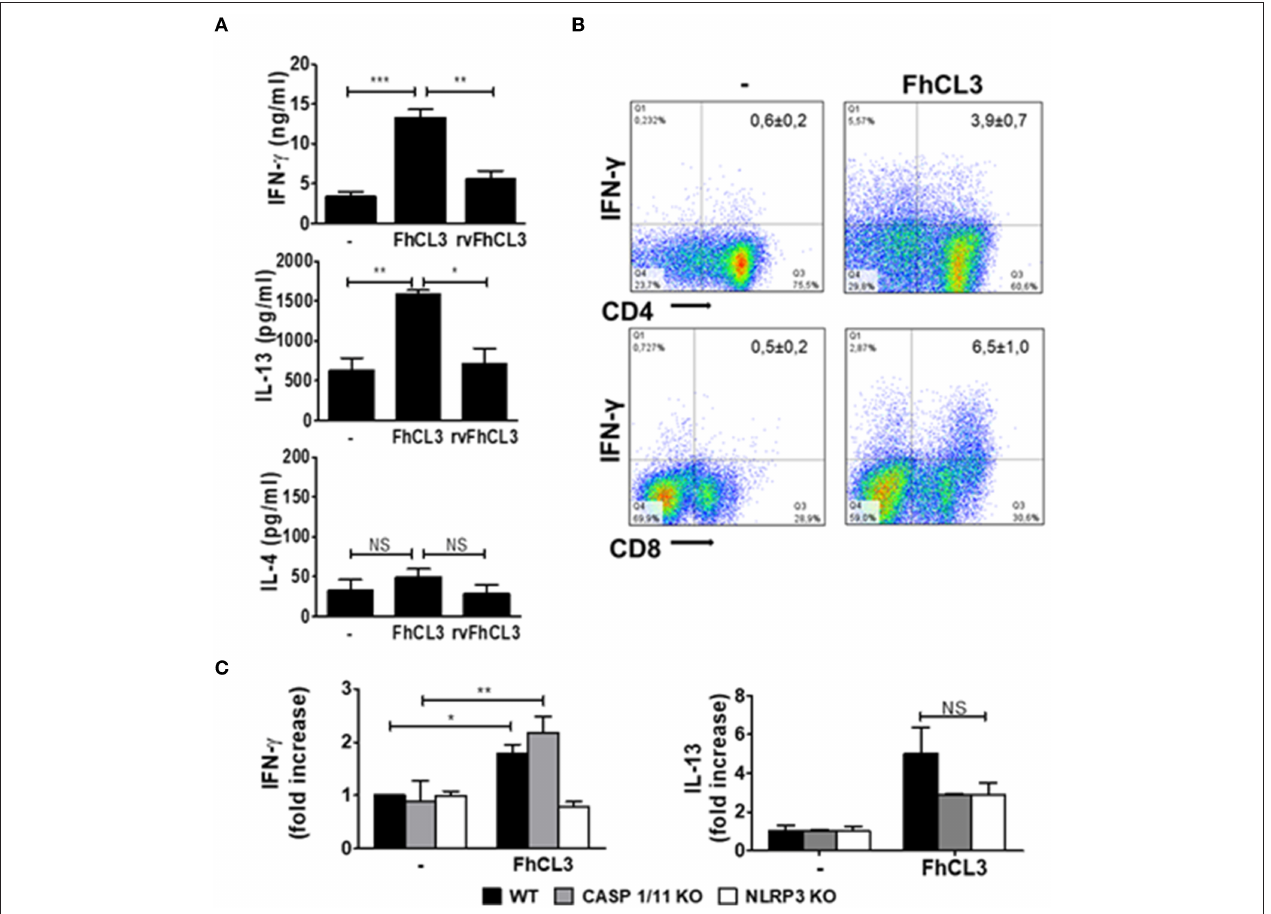
FIGURE 6 | FhCL3-treated DCs induce an IFN- γ and IL-13 response in allogeneic cultures. DCs from WT, CASP1/11 KO or NLRP3 KO (all C57BL/6 background) were treated with medium, FhCL3 (10 µ g/mL) or rvFhCL3 (10 µ g/mL) for 18h and co-cultured with allogeneic splenocytes from BALB/c mice. (A) At day 5, IFN- γ , IL-4 and IL-13 concentrations were measured in supernatants by ELISA. (B) The splenocytes were stimulated with PMA/Ionomycin for 4h and analyzed by flow cytometry. IFN- γ expression was evaluated on CD4 + and CD8 + T cells on CD3 + gated population by flow cytometry. Data are showed in representative dot plot diagram of three or four independent experiments. In the upper quadrants the values indicate the percentages as mean ± SD. (C) IFN- γ and IL-13 production were determined in culture supernatants by ELISA. The concentrations were normalized according to a ratio of IFN- γ or IL-13 detected in culture supernatant of allogeneic splenocytes cultured with FhCL3-treated DCs vs. unstimulated DCs. Results are presented in bars graph as means ± SD and are representative of three experiments. NS, not significant, * p < 0.05; ** p < 0.01; *** p < 0.001 (ANOVA